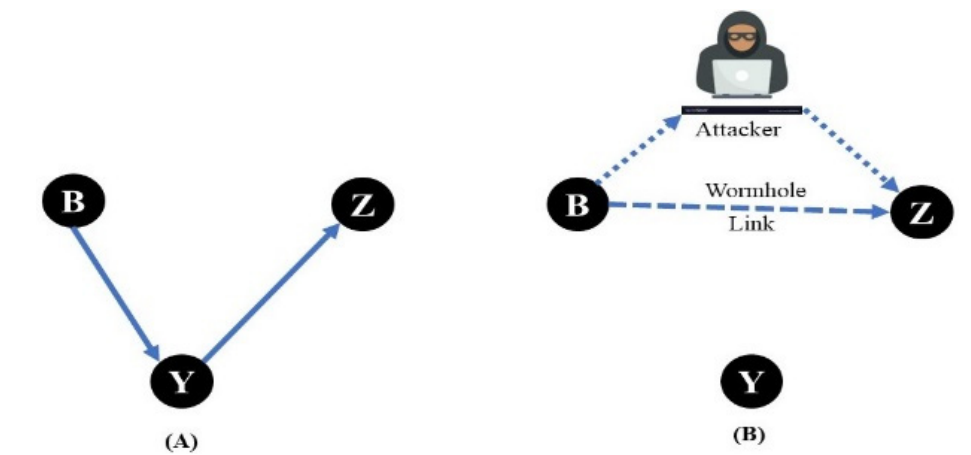
Figure 9. ( A ) Wireless Sensor Network with three locations. ( B ) Wormhole attack by attacker.